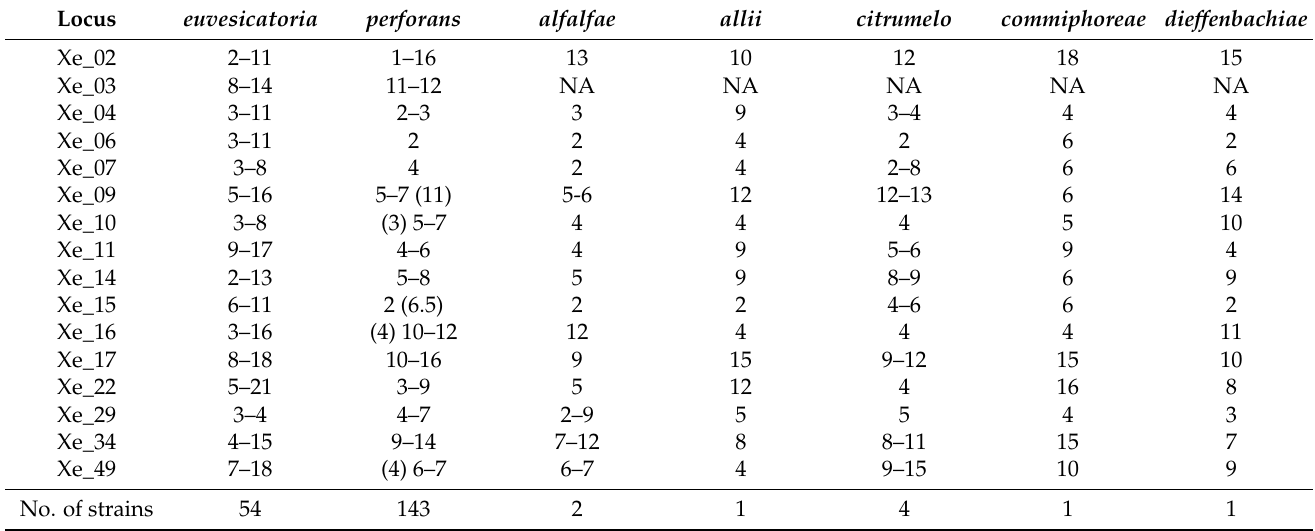
Table 6. Allelic range of VNTR loci from different pathovars of Xanthomonas euvesicatoria .